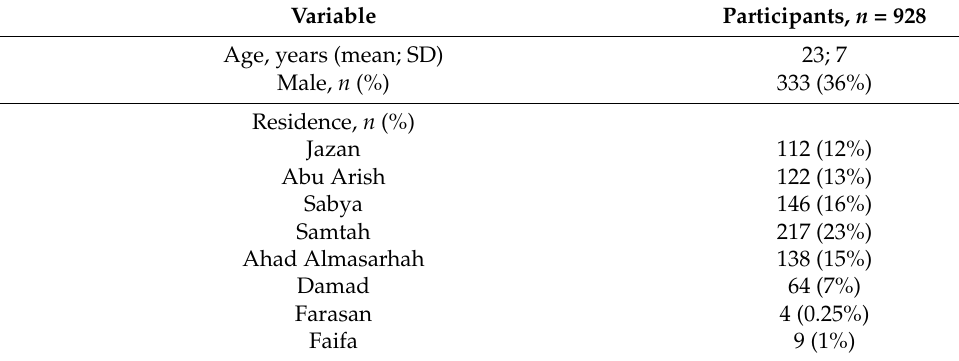
Table 1. General characteristics of the participants in our